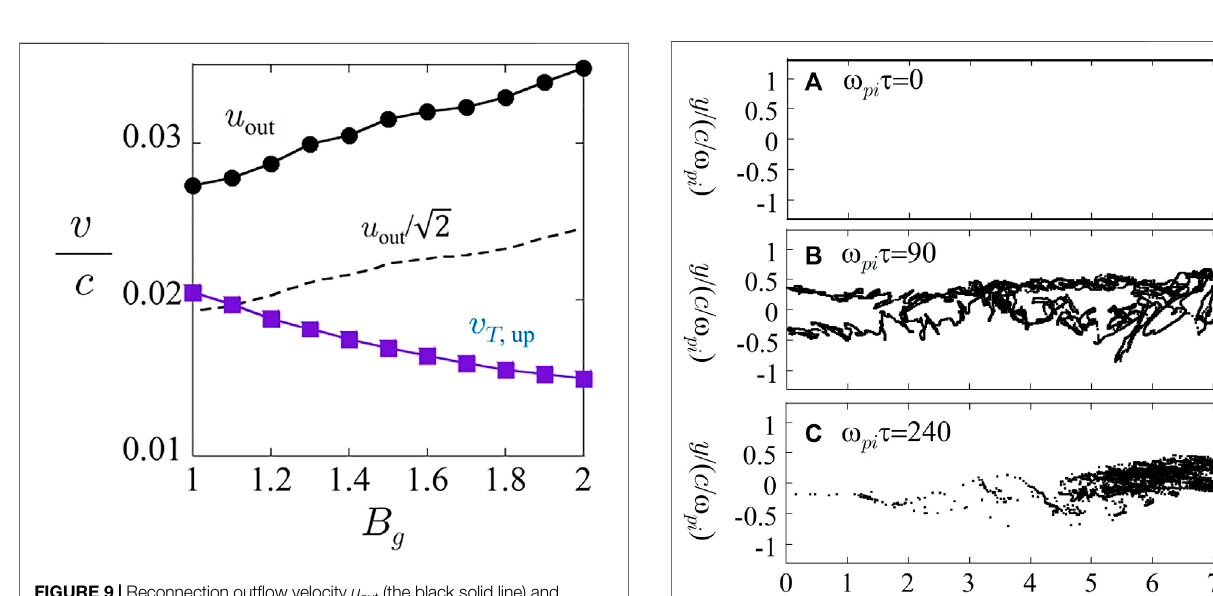
(cid:5)(cid:5) √ 2 (the black dashed line) FIGURE10| Positions oftheionscalculatedbyatest particle simulation (A) : at ω pi τ = 0 (B) : at ω pi τ = 90, and (C) : at ω pi τ = 240.